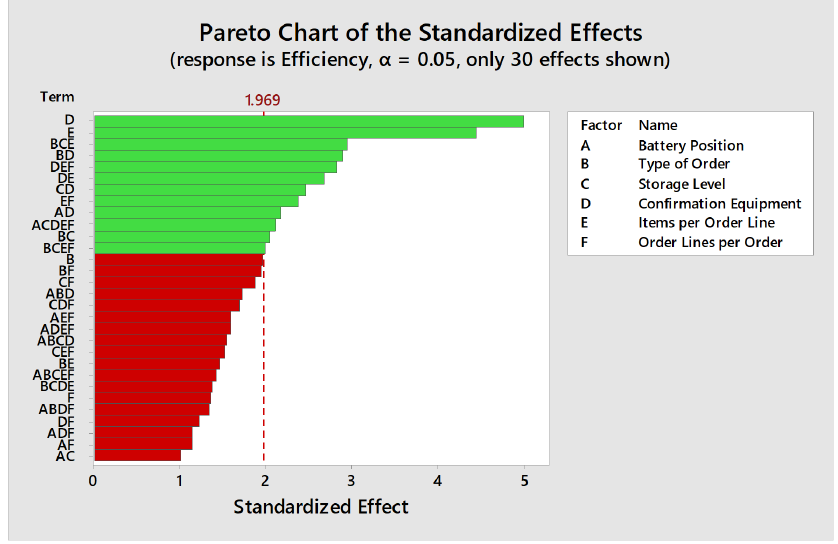
Figure 9. Pareto chart for order-picking efficiency.